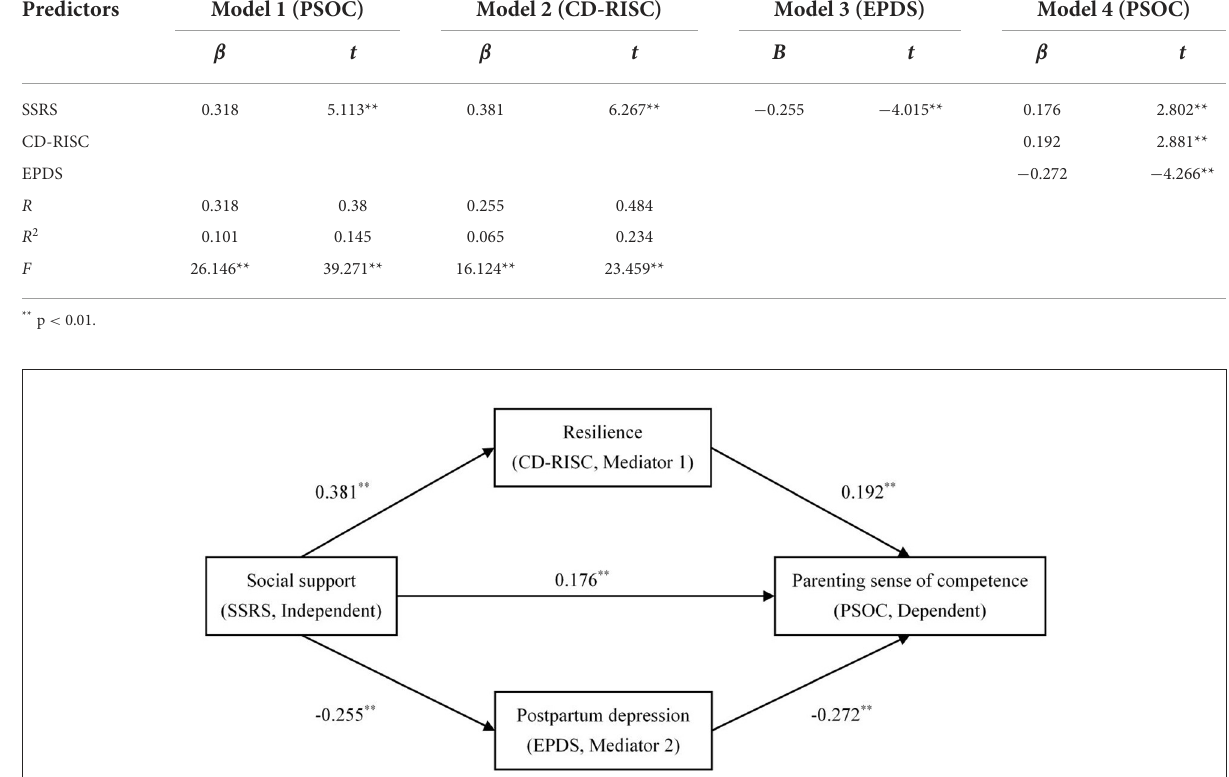
TABLE 3 Multiple mediating models between social support and parenting sense of competence.